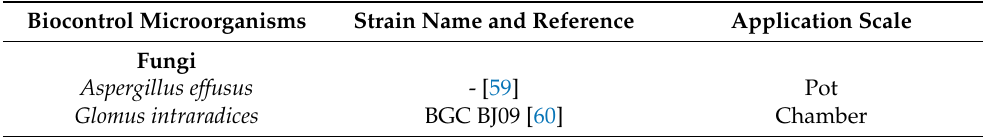
Table 2. Overview of biocontrol agents showing control ability against